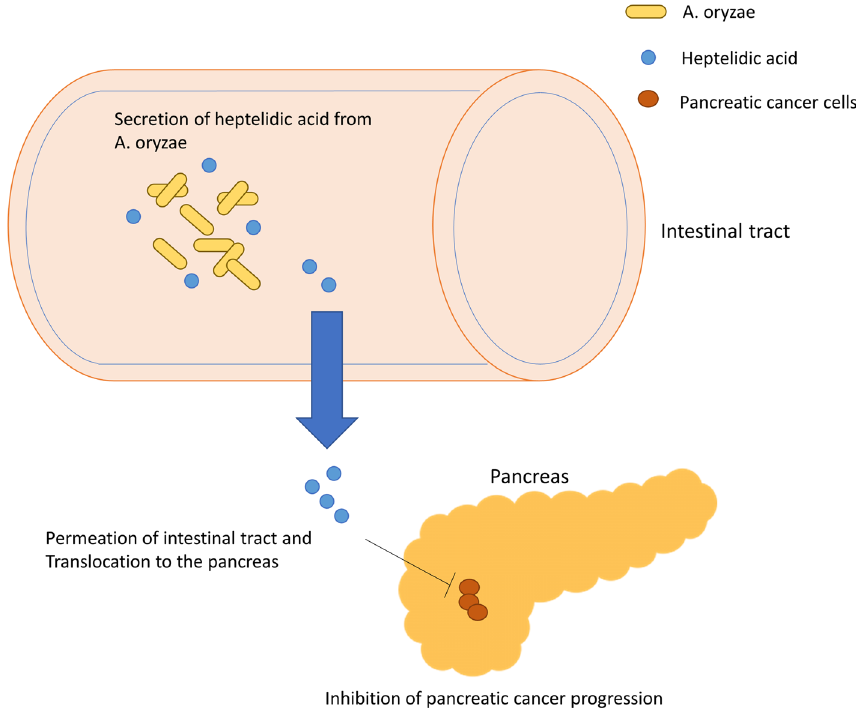
Figure 6. A schematic illustration of the regulatory systems of pancreatic cancer mediating A. oryzae . Heptelidic acid secreted by A. oryzae can circulate throughout the intestinal tract to enter the host whole body and thereafter it translocates to the pancreas, where it then inhibits the growth of pancreatic